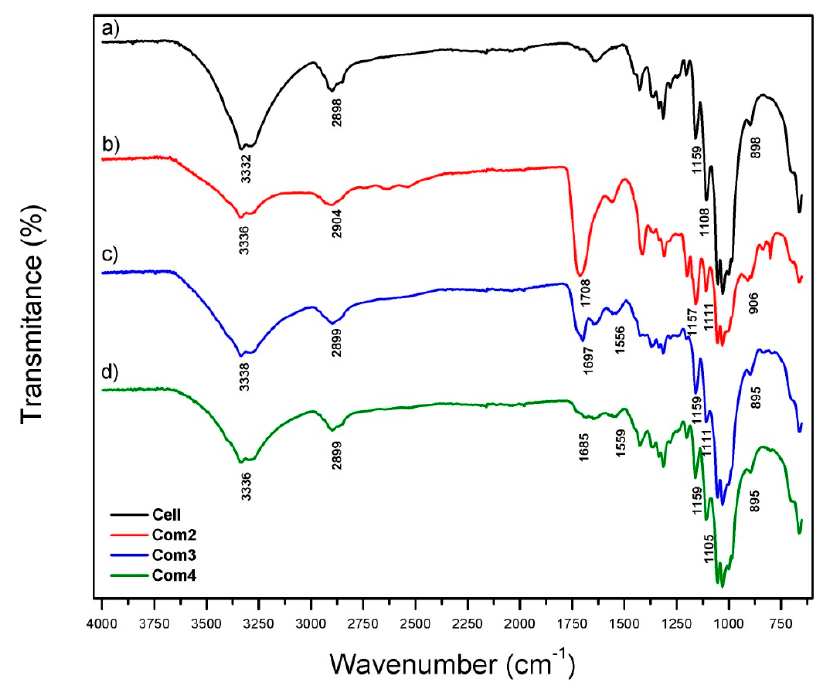
Figure 2. Comparative FTIR spectrum of (a) cellulose, (b) Com-1, (c) Com-3, and (d) Com-4.